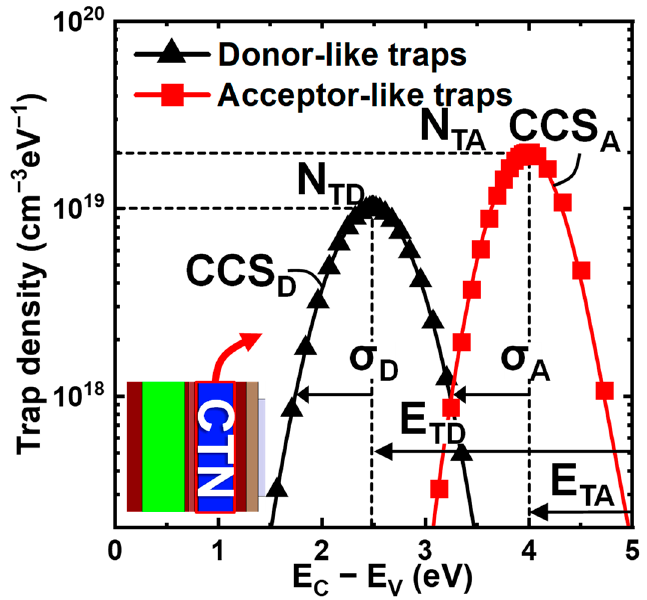
Figure 2. Two energetic-trap distributions comprising donor- and acceptor-like traps of the CTN. The peak energy levels ( E TD and E TA ) are from the conduction band ( E C ). Their profiles determine the V th window.